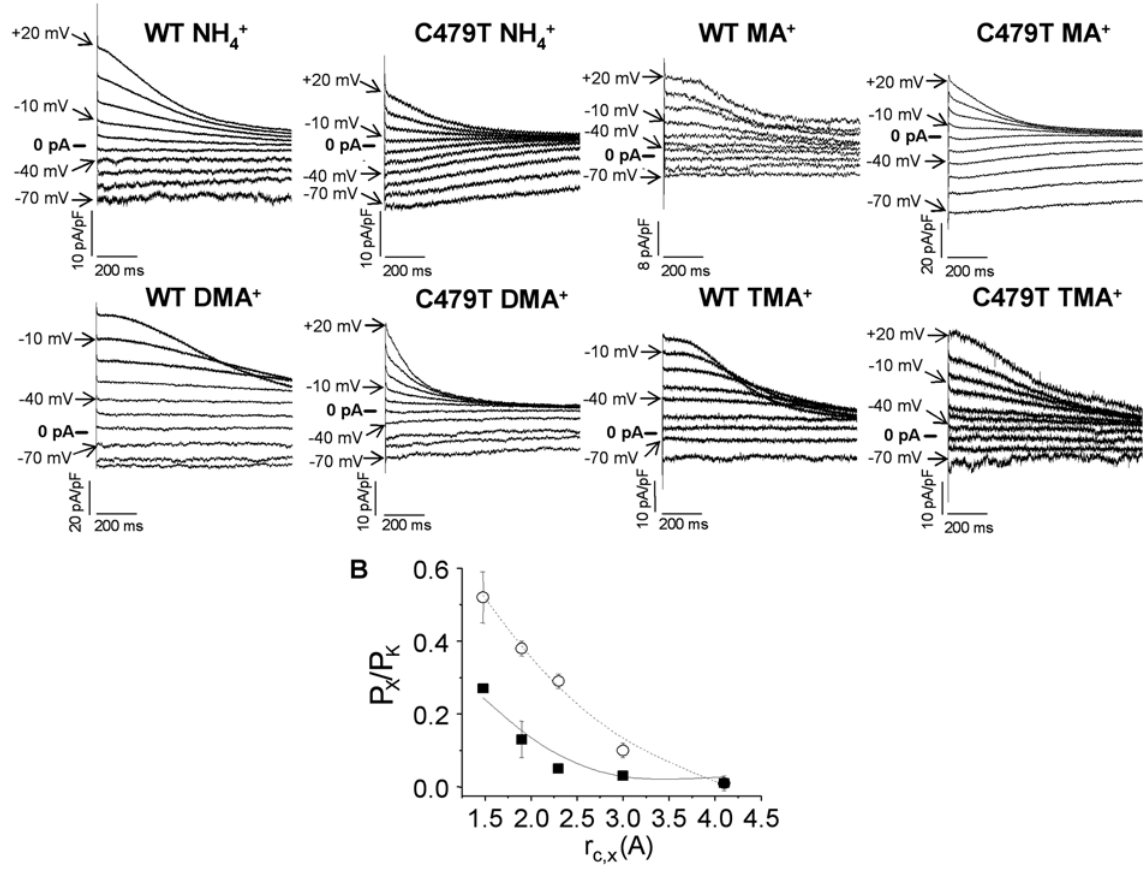
Figure 4. Pore size estimates for WT and C479T HCN4 channels. (A) Sample tail currents elicited following an activating ‘‘pre-pulse’’ to 2 130 mV as shown in Figure 1B for experiments performed in 5 mM K + and 135 mM X + (NH 4 + , MA + , DMA + and TMA + ) extracellular bath solution. Using ‘‘Exclusive Field Theory’’ we estimated the minimum pore diameter by plotting P X /P K of organic cations NH 4 + , MA + , DMA + , TMA + , and TEA + for WT ( & ) and C479T ( # ) channels versus the ionic crystal radius according to Equation (2.15). Fits of these data gave minimum pore diameters of 6.9 6 0.4 A˚ (R=0.93) and 8.7 6 0.3 A˚ (R=0.99) for WT and C479T channels respectively (P , 0.05).